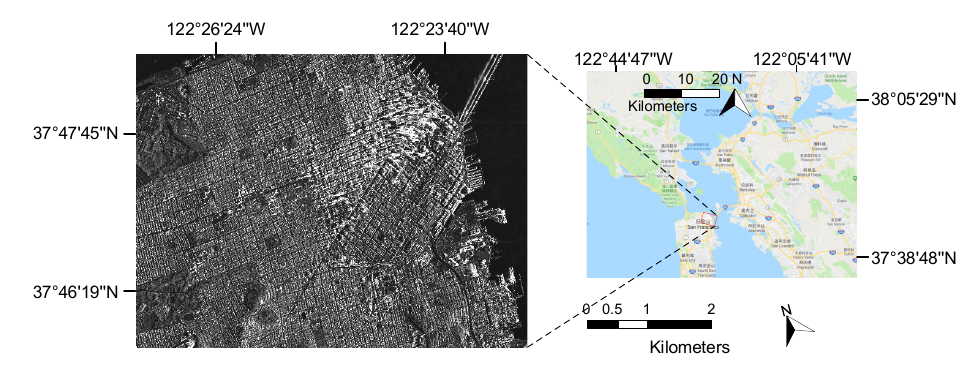
Figure 7. SAR image of Data Set 2.